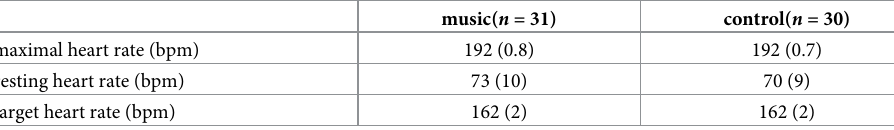
Table 2. Means and standard deviations for heart rate. Mean ( SD